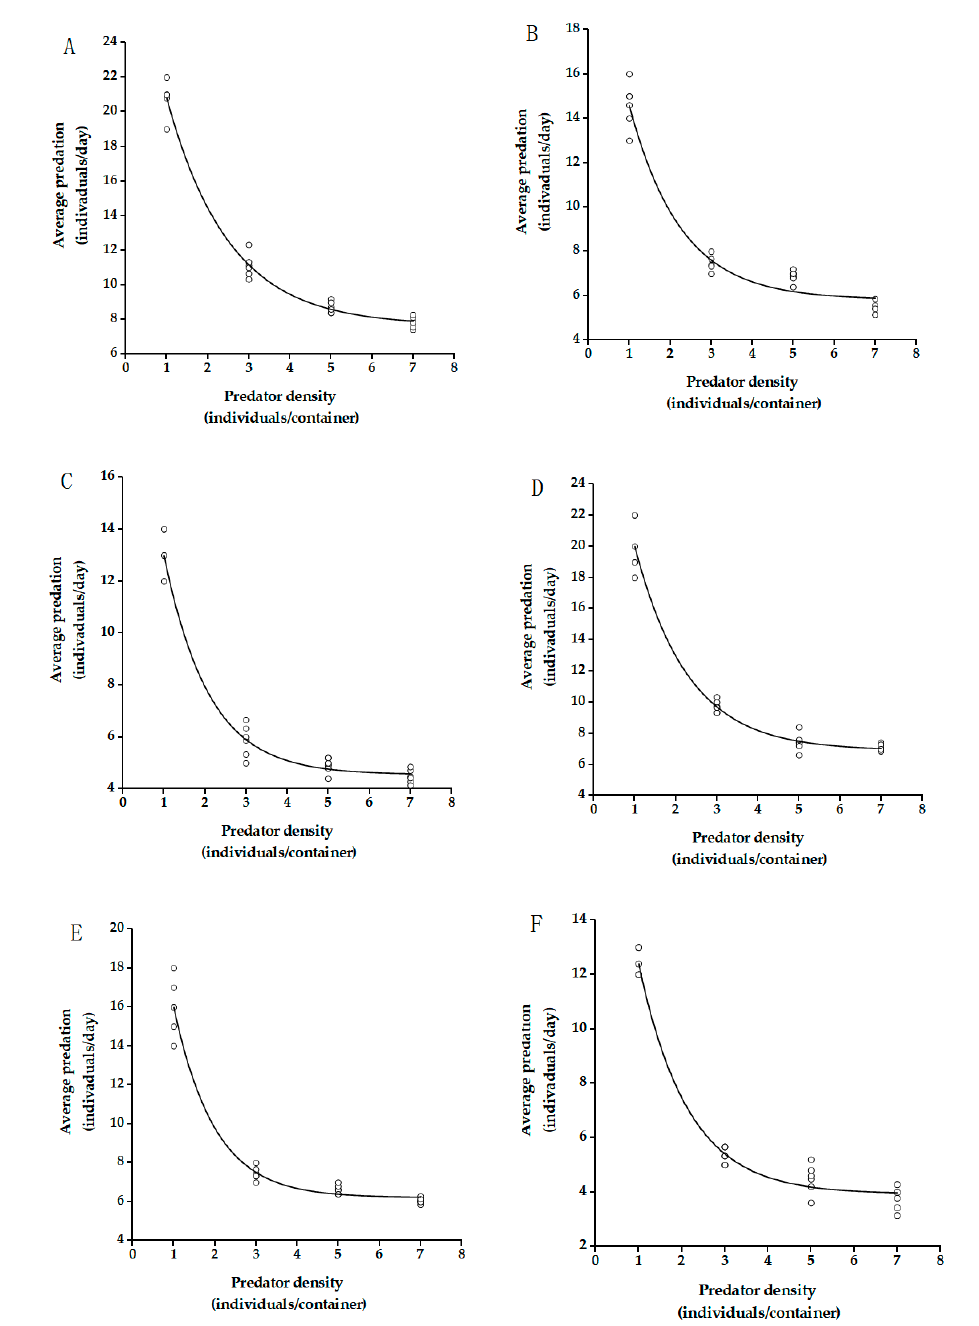
Figure 3. Interspecific disturbance responses of male and female adults of C. elysii preying on A. agrestis ; interspecific interference response of female adults to juvenile ( A ), immature ( B ), and adult ( C ) A. agrestis ; Interspecific interference response of male adults to juvenile ( D ), immature ( E ), and adult ( F ) A. agrestis . Each data point represents the average predation of C. elysii adults at different densities. Curves were fitted using the intraspecific competition equation (Equation (3)). Table 2. Interference response coefficients of C. elysii density to distinct sizes of A. agrestis.